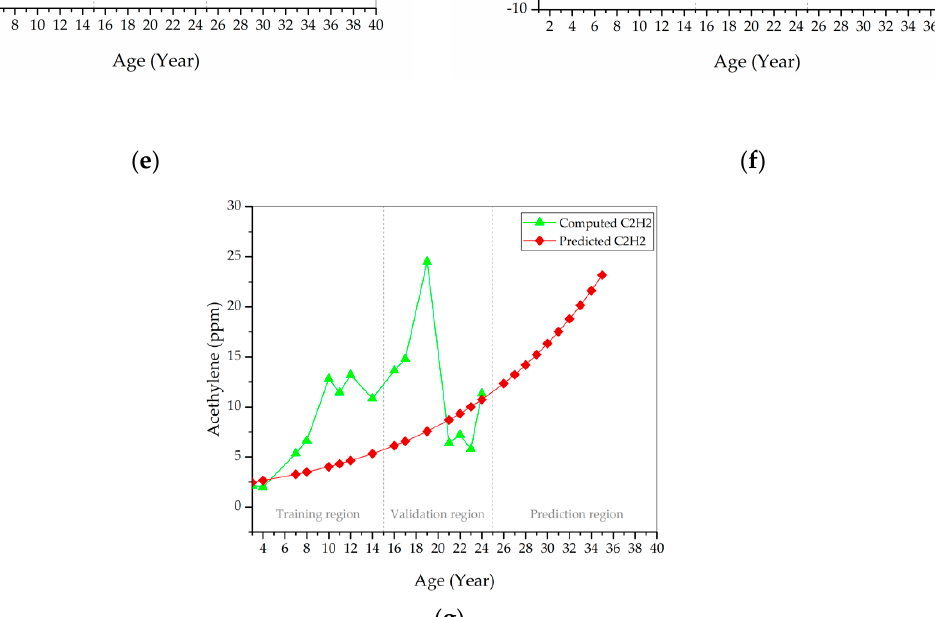
Table 5. The representative distribution for dissolved gas parameters data. Parameter